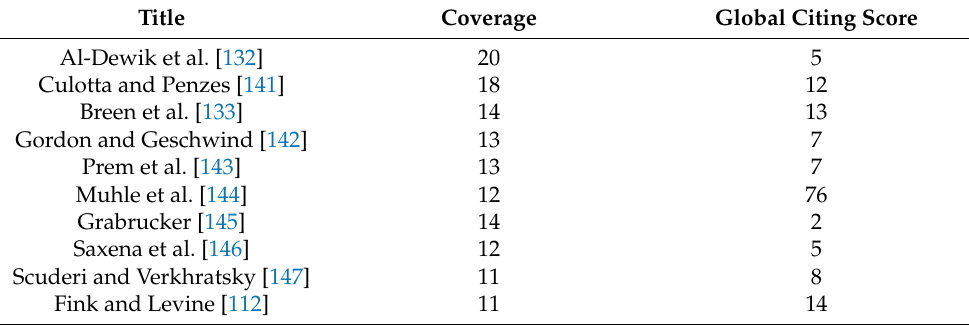
Table 9. Top 10 citing papers in Cluster #5 identified using DCA.